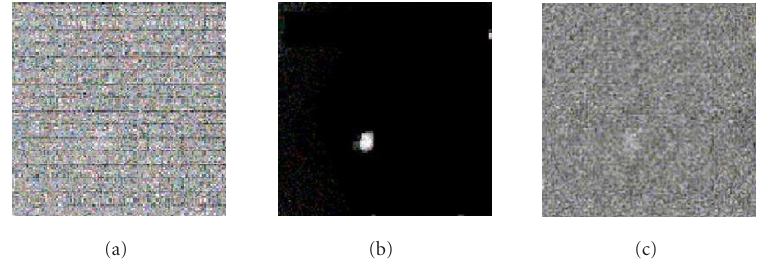
Figure 1: Example of an infrared image. (a) Raw image at 1500- second integration time. (b) One interesting object in the image “Galaxy SBS-0335-05210.” (c) Resulting image after denoising (noise from the